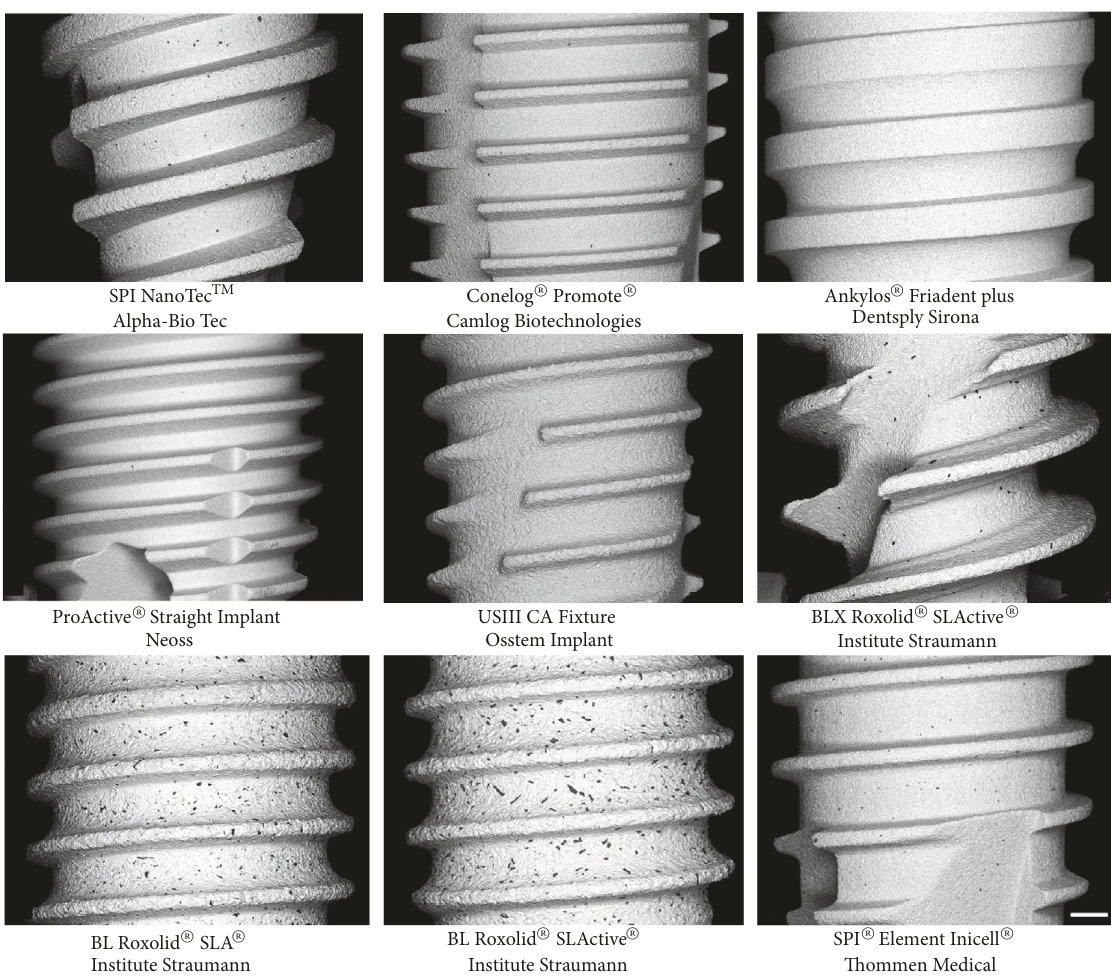
Figure 3: Backscatter-SEM micrographs of the analyzed implant systems. Note the various numbers and sizes of the Al 2 O 3 particles (black dots) remaining on the surface following etching. Scale bar: 200 𝜇